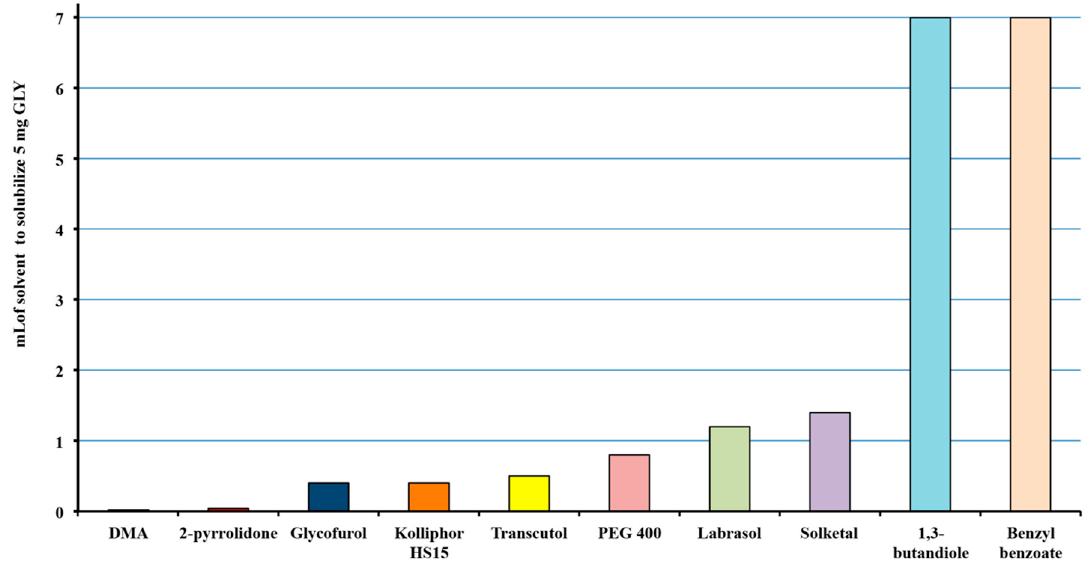
Figure 1. Solubility of glyburide (GLY) in the different solvent examined, expressed as mL of solvent necessary to solubilize 5 mg drug (therapeutic single dose).